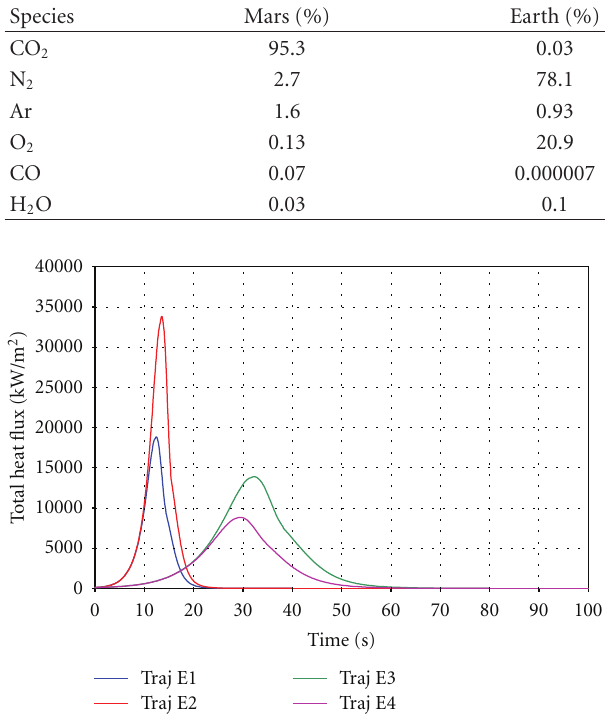
Figure 1: Total heat flux versus time for di ff erent entry trajectories during EVD mission